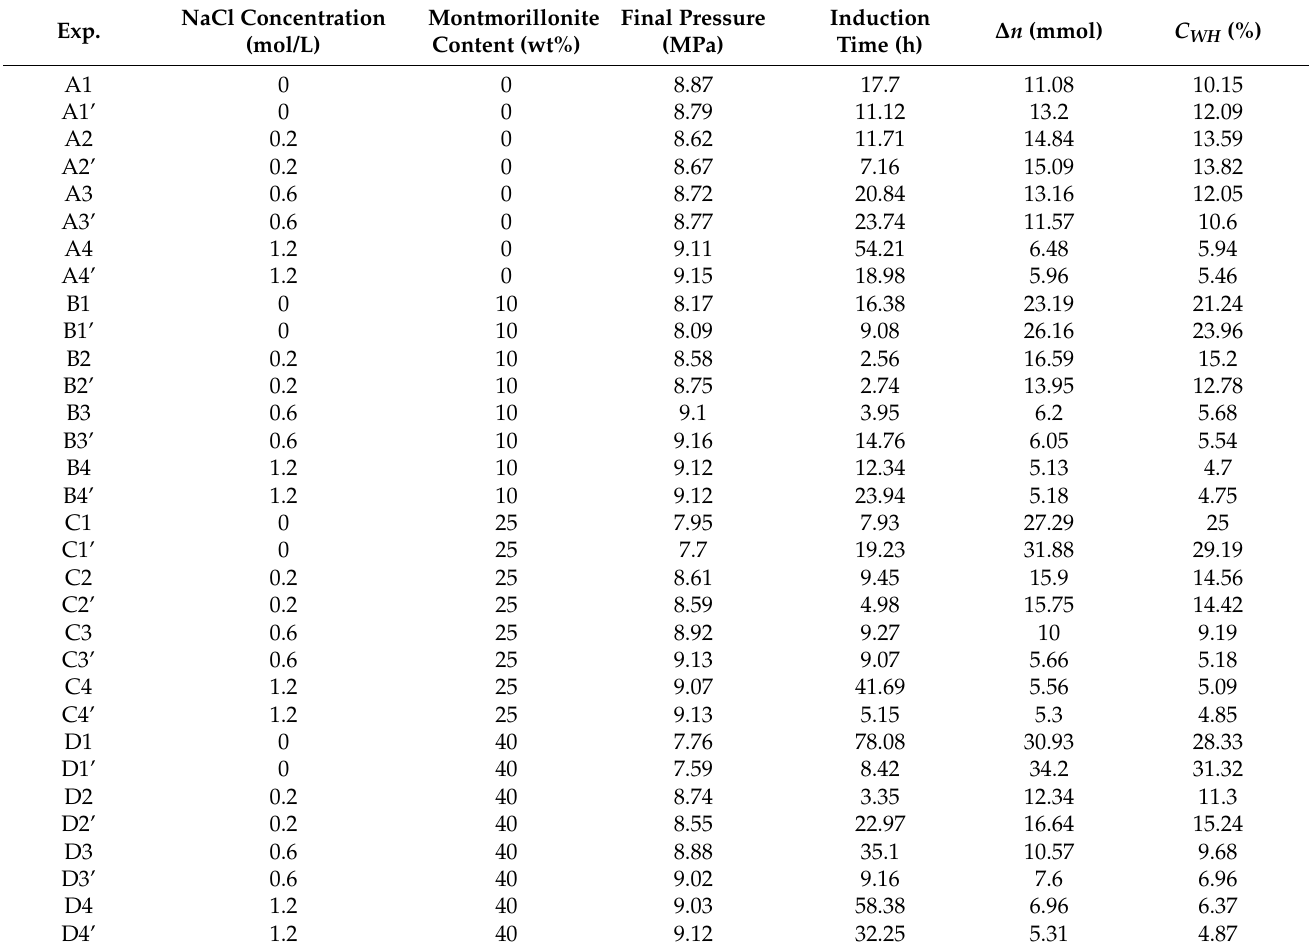
Table 2. Summary of experimental conditions and